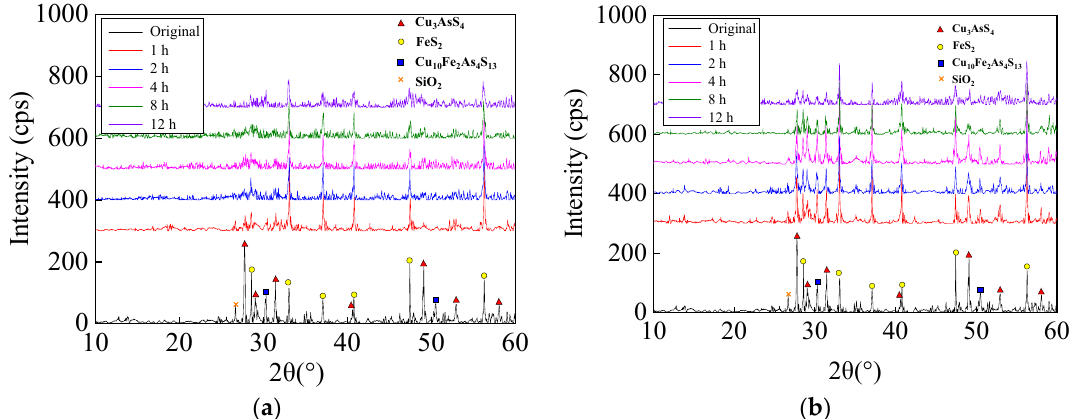
Figure 4. XRD analysis of dry and wet grinding as an effect of grinding time; ( a ) dry grinding; ( b ) wet grinding.